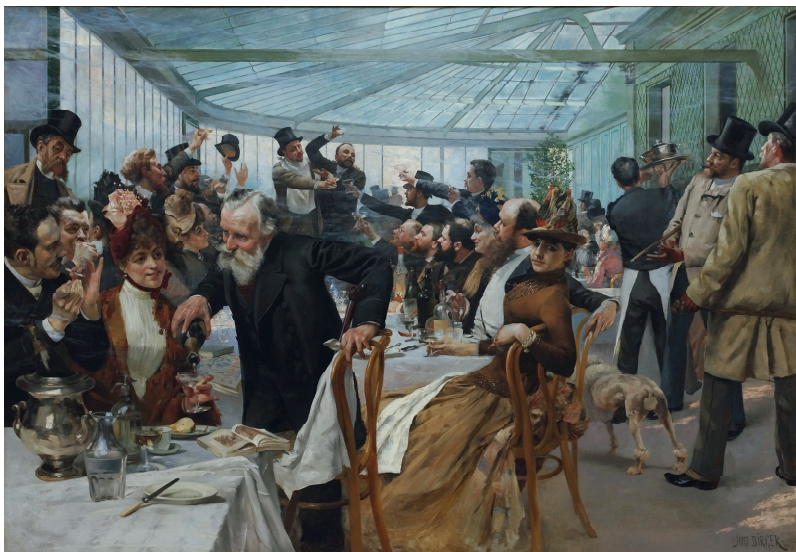
Figure 4. Hugo Birger (1854–1887): Skandinaviska konstnärernas frukost i Café Ledoyen, Paris